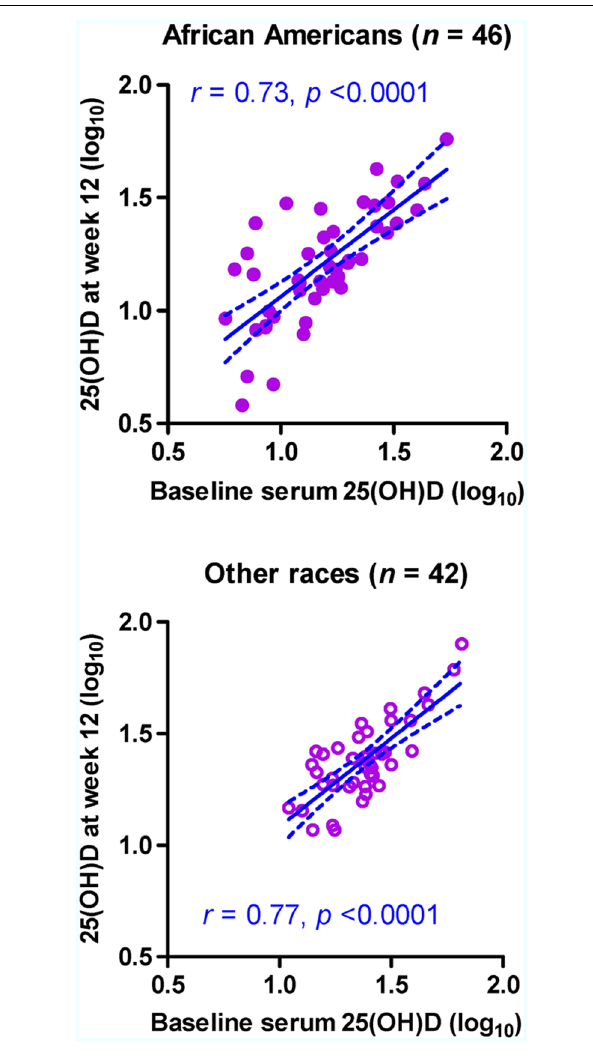
FIGURE 1 | Stability of serum 25-hydroxyvitamin D [25(OH)D] concentration (ng/ml) in 88 HIV-1-infected youth who did not receive randomized vitamin D supplementation over a 12-week period. Measurements at baseline (week 0) and at study week 12 are shown for 46 African–Americans (AAs) and 42 non-AA subjects (others).The predicted slope and its 95% confidence intervals in each subgroup are represented by sold and dotted lines, respectively. Six subjects (four AAs and two others) with missing data at week 12 are excluded.